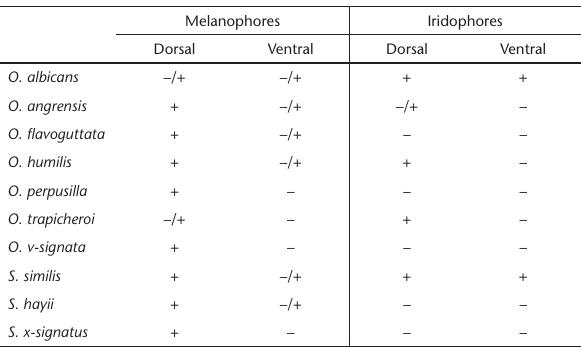
Table 5. Occurence of pigment cells in the integument of Oloygon spp. and Scinax